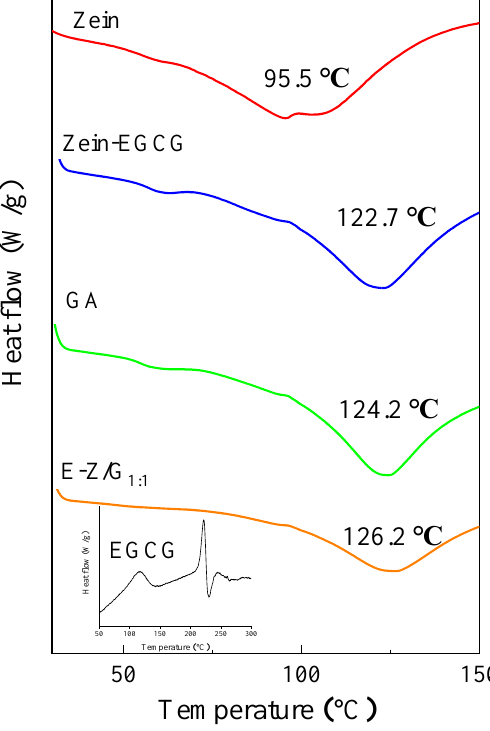
Figure 6. The DSC analysis of different samples.